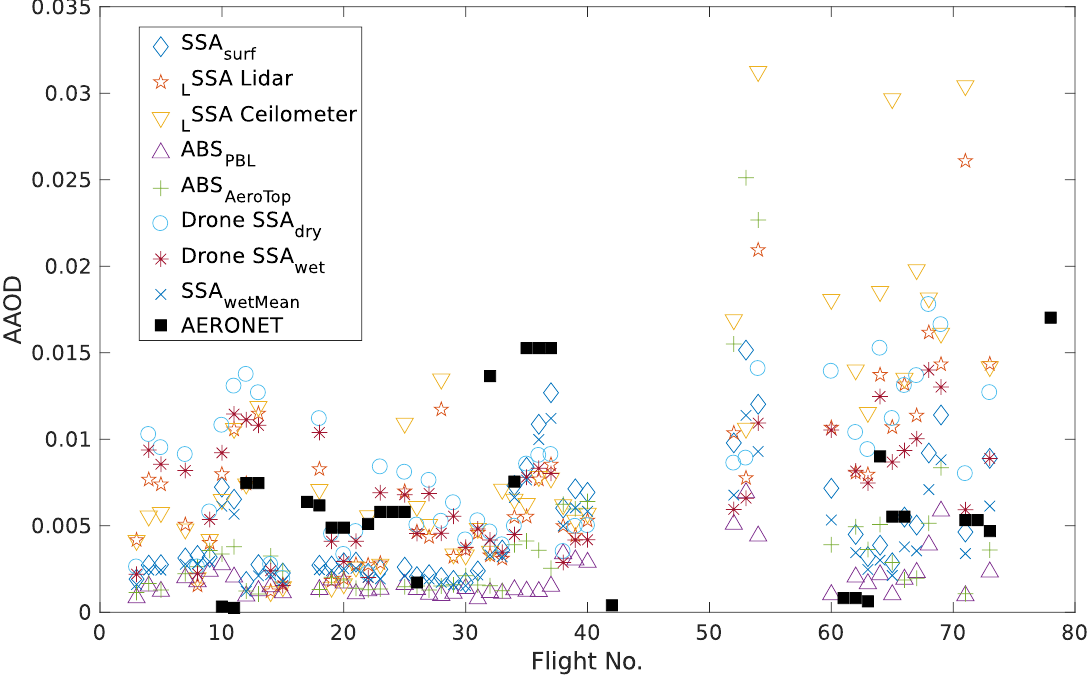
Figure 16. AAOD approximated by different